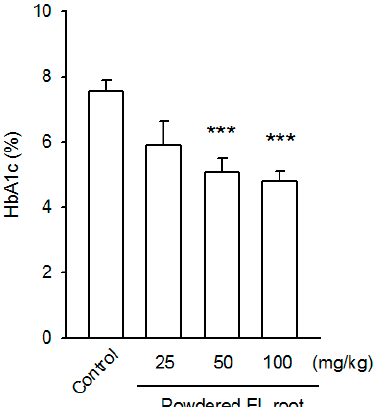
Figure 1. E. longifolia reduced glycated hemoglobin (HbA 1c ) content in db / db mice. The administration of 50 and 100 mg / kg EL powdered root for 8 weeks significantly reduced the percentage of HbA 1c , as compared to the control group. (*** p < 0.001, indicates statistically significant di ff erence from the control group). Table 3. E ff ects of powdered E. longifolia root in an Oral Glucose Tolerance Test (OGTT) in db / db mice. Powdered EL